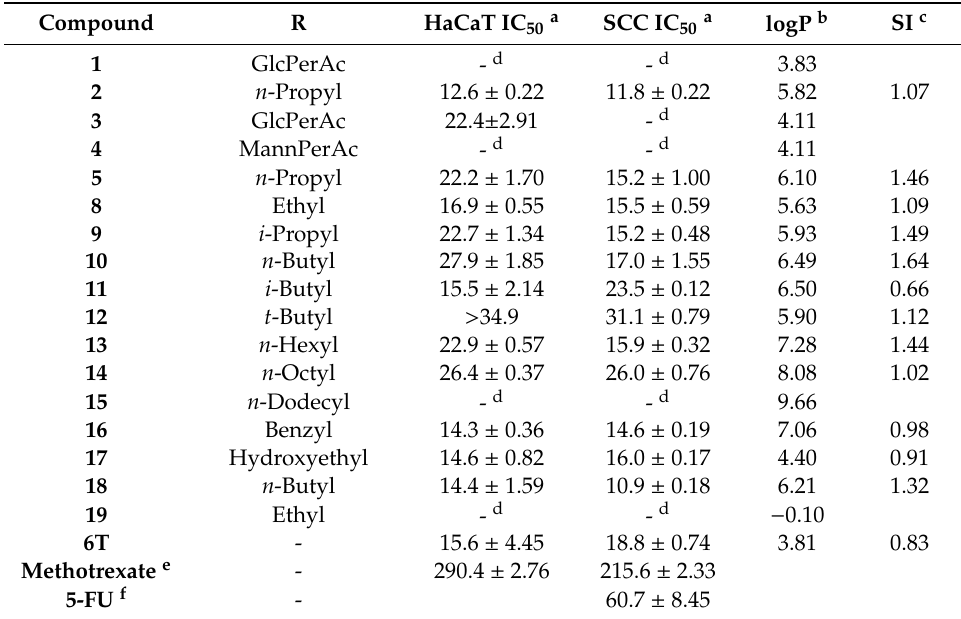
Table 3. Cytotoxic activity of the modified nucleoside